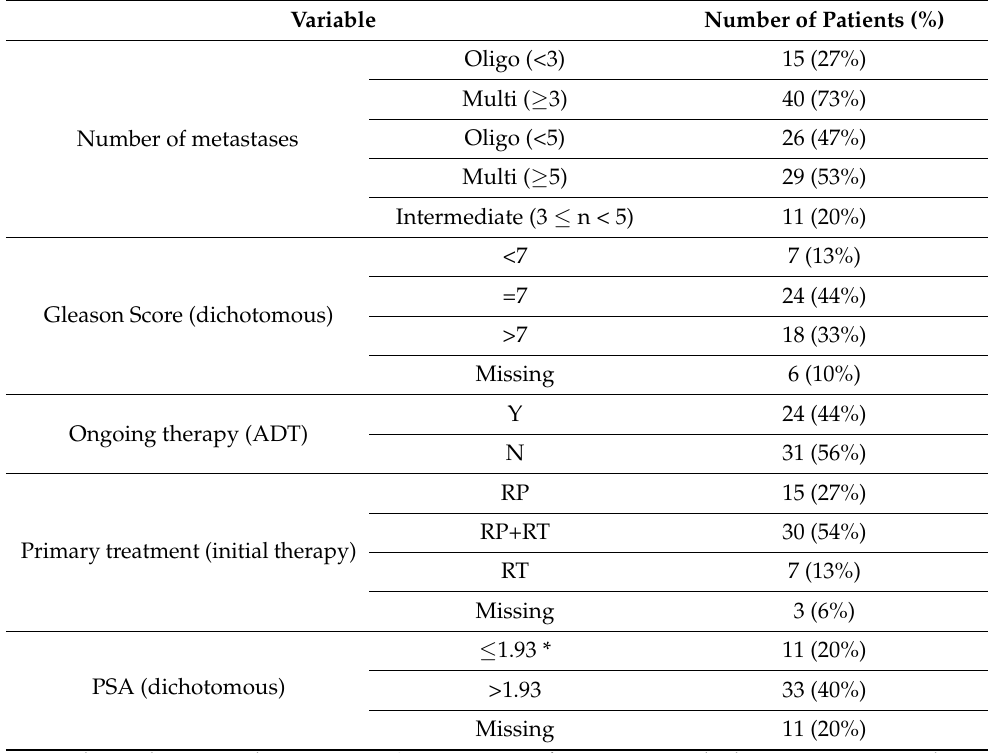
Table 1. Baseline patient